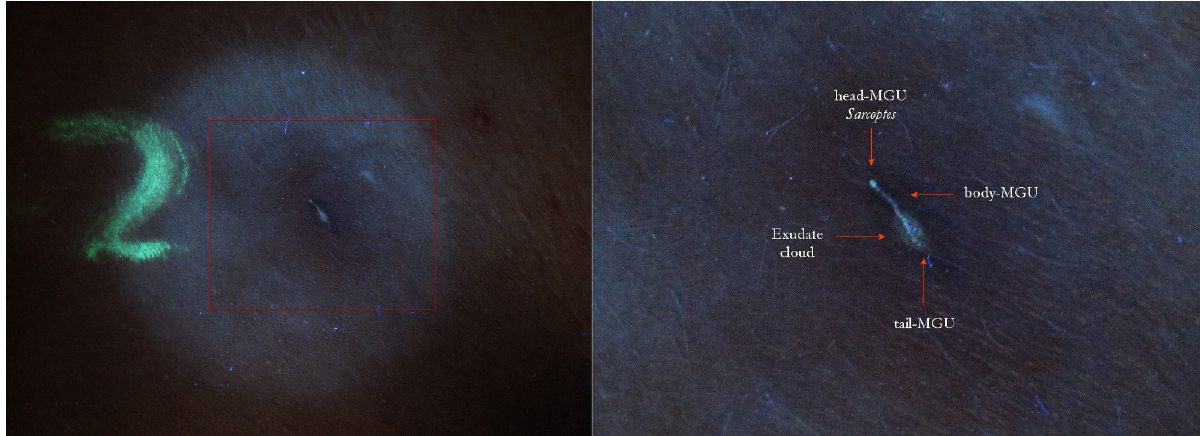
Figure 4. The same lesion under UVA light showed a linear white luminescence (left, red box). In full ‐ frame vision ( right ), it was possible to distinguish a Mite ‐ Gallery Unit whose head part was occupied by Sarcoptes , which featured a green hue (green dot). Between body and tail MGU, there was a luminescent cloud caused by exudate and phlogosis around burrow (rocket sign). A yellow highlighter was used.